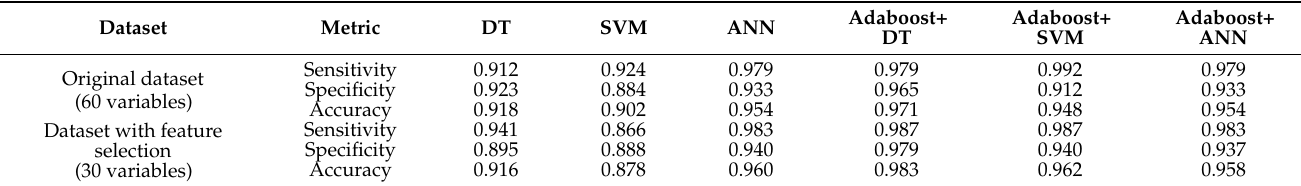
Table 3. Prediction performance of different